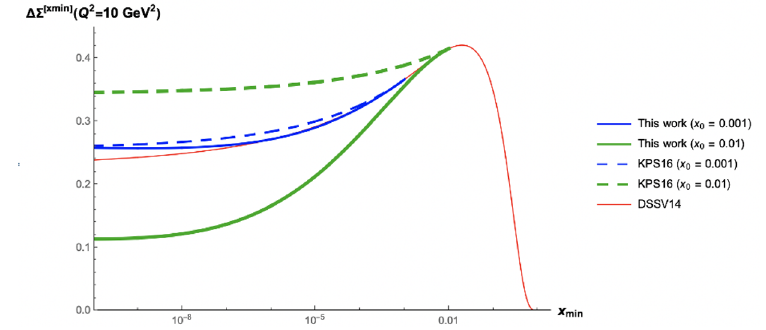
Figure 6 . Plots of (cid:1)(cid:6) [ x min ] ( Q 2 = 10 GeV 2 ) de(cid:12)ned in eq. (5.2) versus x min . The thin (red) line is DSSV14 [6], while the thick (green) and medium-thick (blue) solid lines show the results of matching our asymptotics (5.1) to DSSV14 at x 0 = 0 : 01 and x 0 = 0 : 001, respectively. The two dashed lines represent the small- x extrapolation done in [2] using a power-law expression for (cid:1)(cid:6)( x; Q 2 ) at small x resulting from the large- N c evolution, also matched onto DSSV14 at x 0 = 0 : 01 (thick dashed, green) and x 0 = 0 : 001 (medium-thick dashed,